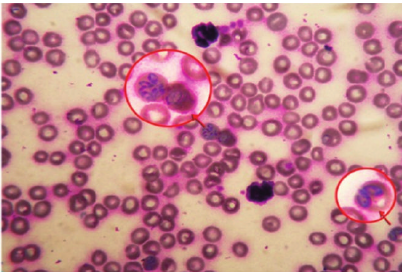
Figure 1: Giemsa-stained blood smear of infected dog showing the pear-shaped large B. canis inside the RBCs ( × 1000).